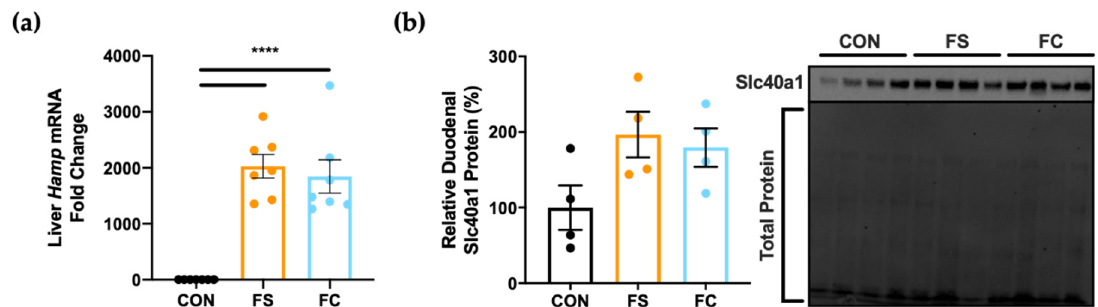
Figure 3. Changes in systemic iron regulation at PD 15. ( a ) Liver hepcidin ( Hamp) mRNA expression was assessed by real-time PCR ( n = 7–8/group). Values with the mean ± SEM are plotted as fold change relative to CON means. ( b ) Relative expression of the iron exporter protein, ferroportin (Slc40a1), was assessed in the proximal small intestine ( n = 4/group). Adjusted Slc40a1 band density was normalized to total protein with the Stain-Free™ method, and values are plotted relative to mean CON expression (%) as the means ± SEM. p -value summary: ****, p < 0.0001.